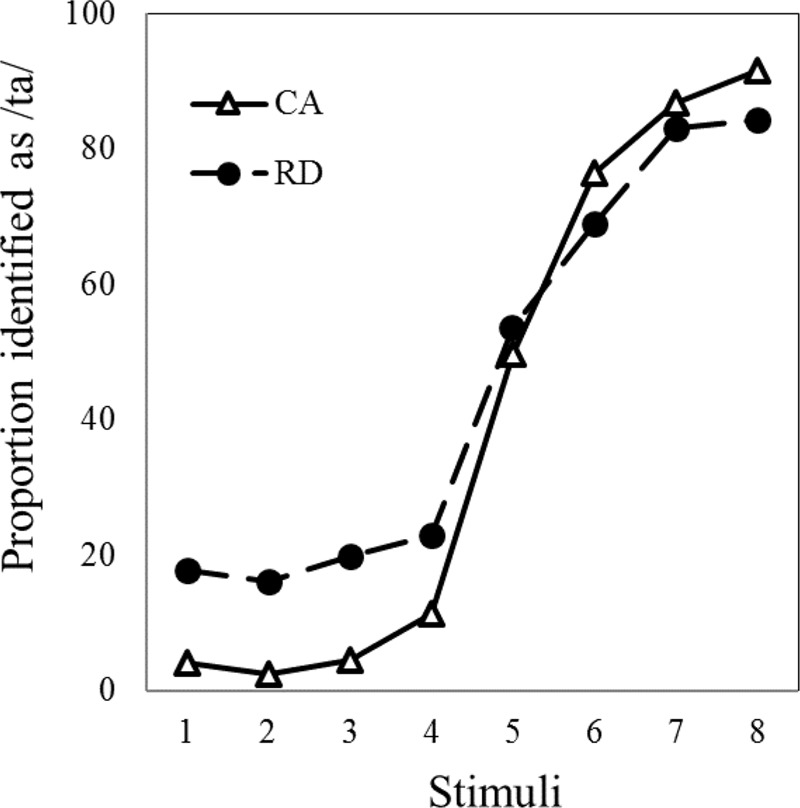
Speech categorization curves in two groups.